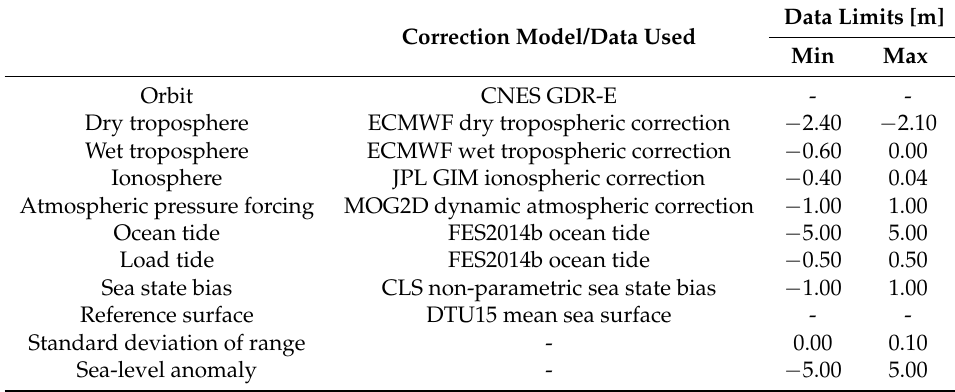
Table 1. Data quality constraints and corrections/models applied onto the radar satellite altimeter data in pre-processing.